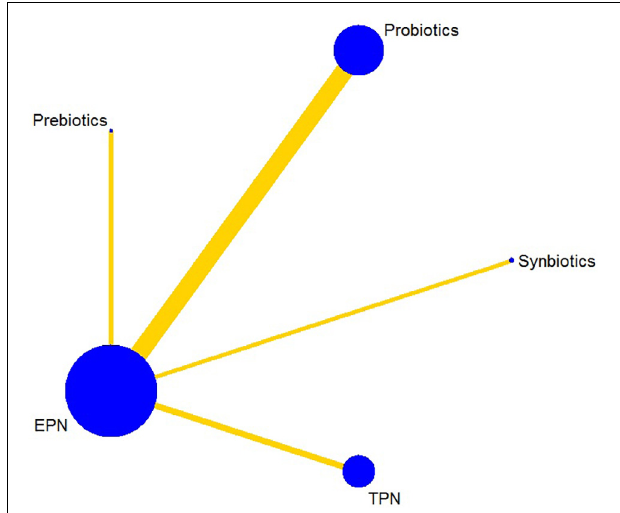
FIGURE 4 | Network plot of all intervention comparisons for ventilator-associated pneumonia. The size of the nodes corresponds to the total number of participants that study the treatments. The (directly) comparable treatments are linked with a line. The thickness of the line corresponds to the standard error of trials that study this comparison. The colors of the line correspond to the quality of trials that study this comparison. Moderate risk of bias [yellow]. EPN, enteral nutrition and/or adjuvant peripheral parenteral nutrition. TPN, total parenteral